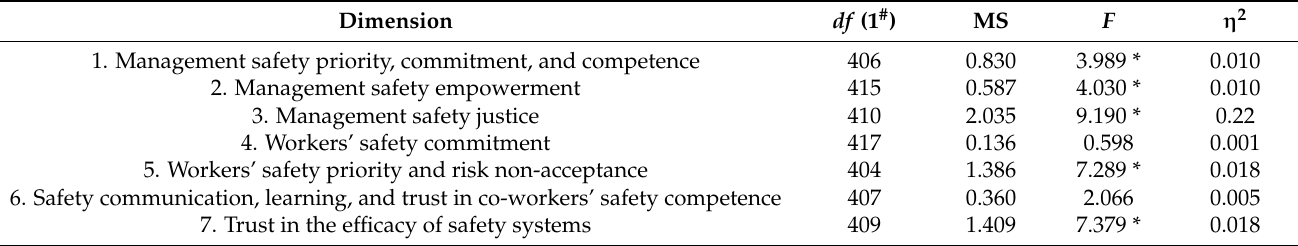
Table 5. Analysis of variance summary for a managerial position measured against the seven dimension considered in the